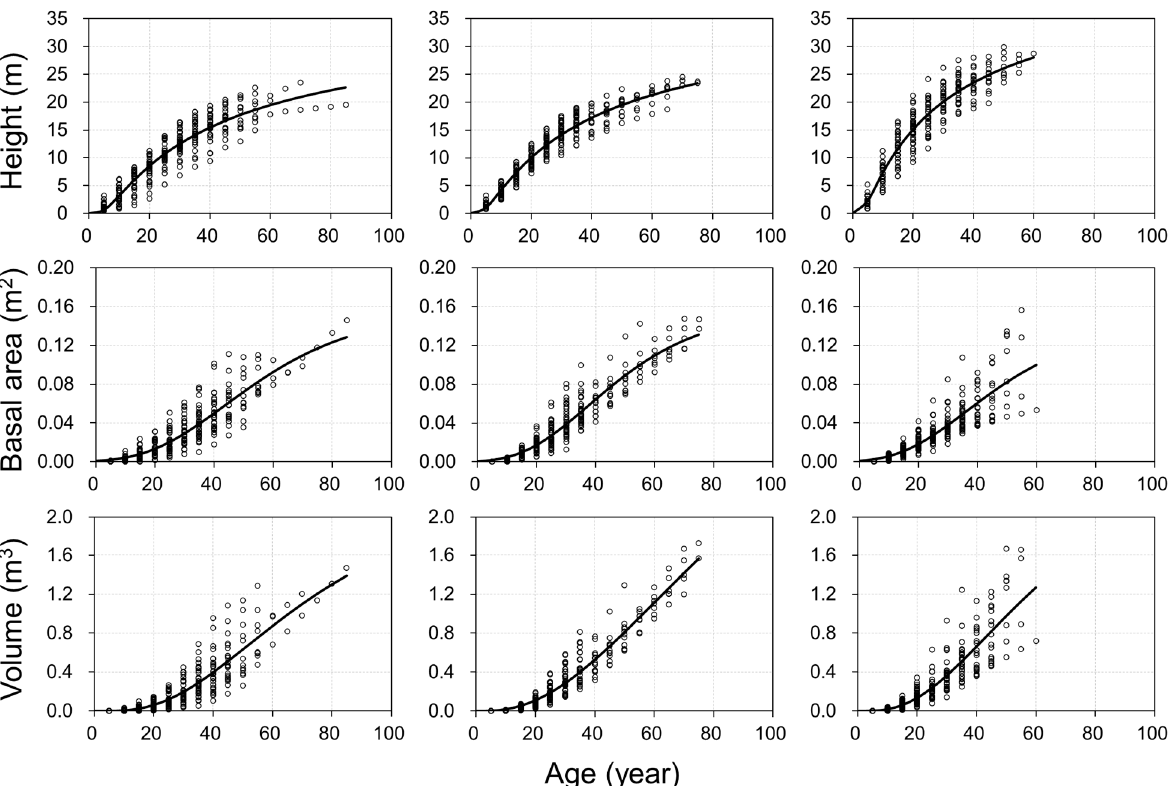
Figure 2. Predicted growth curves and observations of tree size variables by species. The best models by variables were based on fit statistics and model performance; the selected growth functions were Chapman-Richards for DBH and stem volume, Korf for height, and Gompertz for basal area.